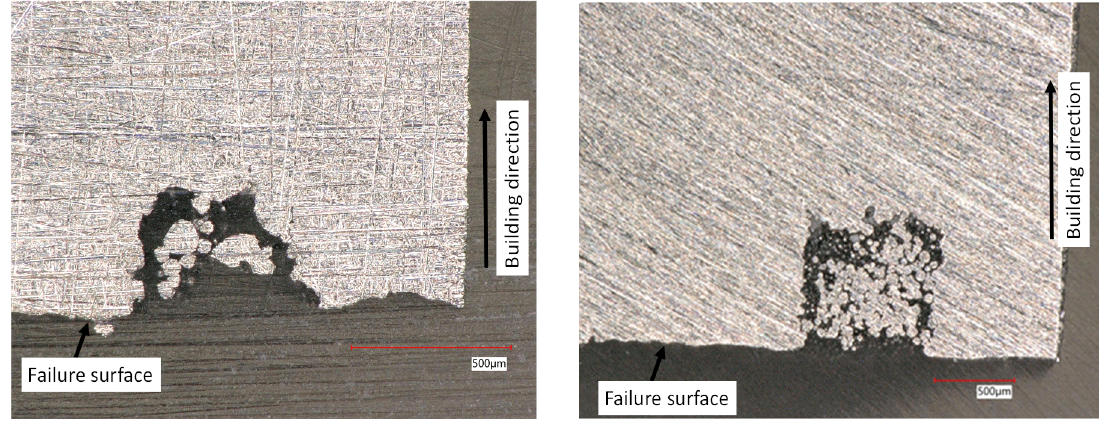
Figure 6. Cross-section of two different fatigue Ti6Al4V coupons in correspondence of the artificial defect. Failure occurred in both samples at the first not-melted